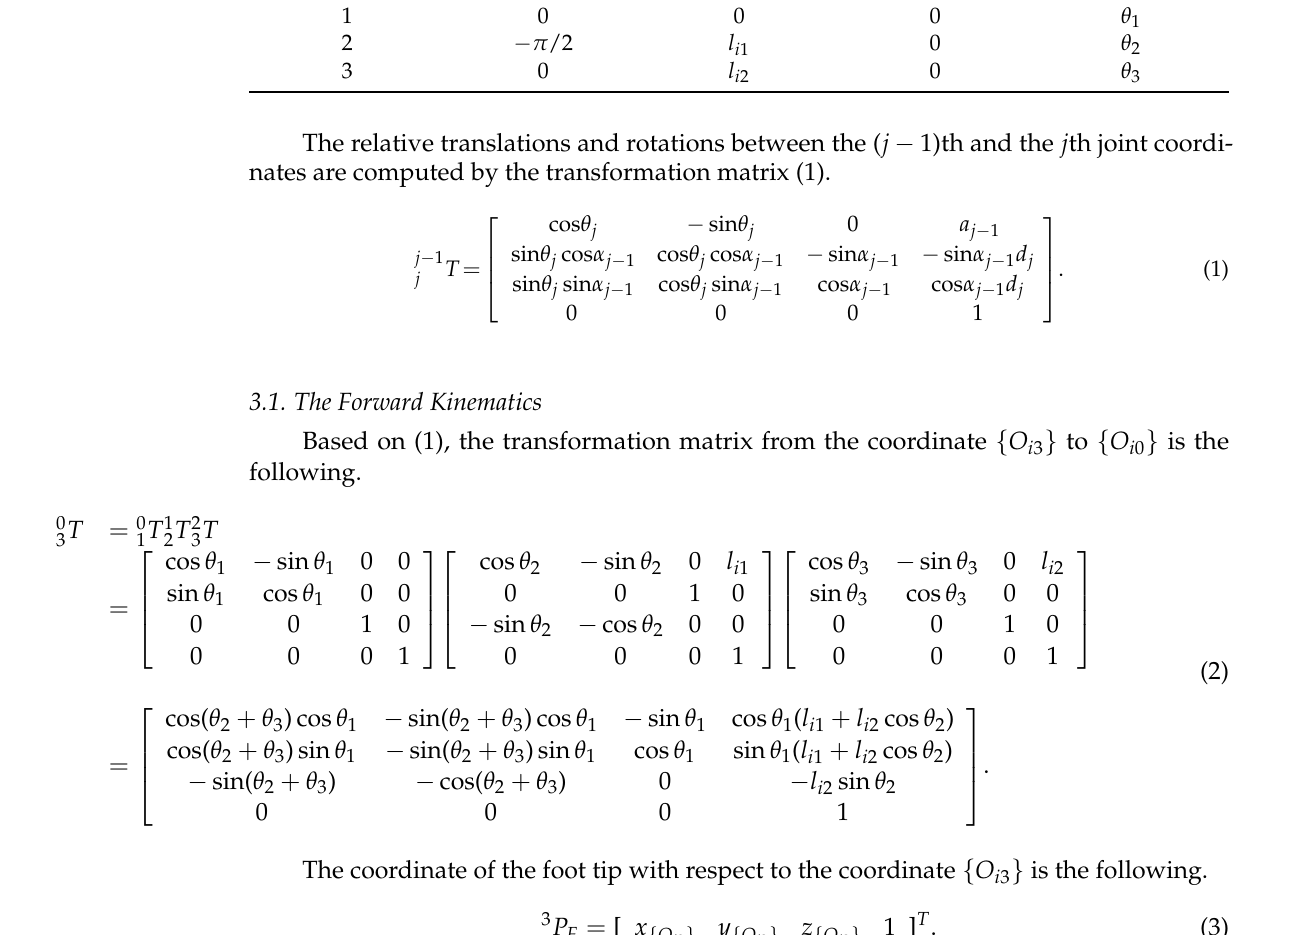
Table 2. Denavit-Hartenberg parameters. Joint j α j −